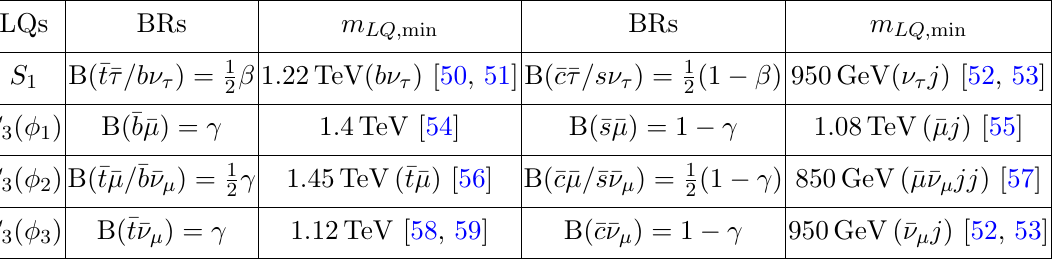
and 1 p and (cid:21) e(cid:11) = j (cid:20) (cid:3) (cid:20) 22 j for R on K ( (cid:3) ) 32 3